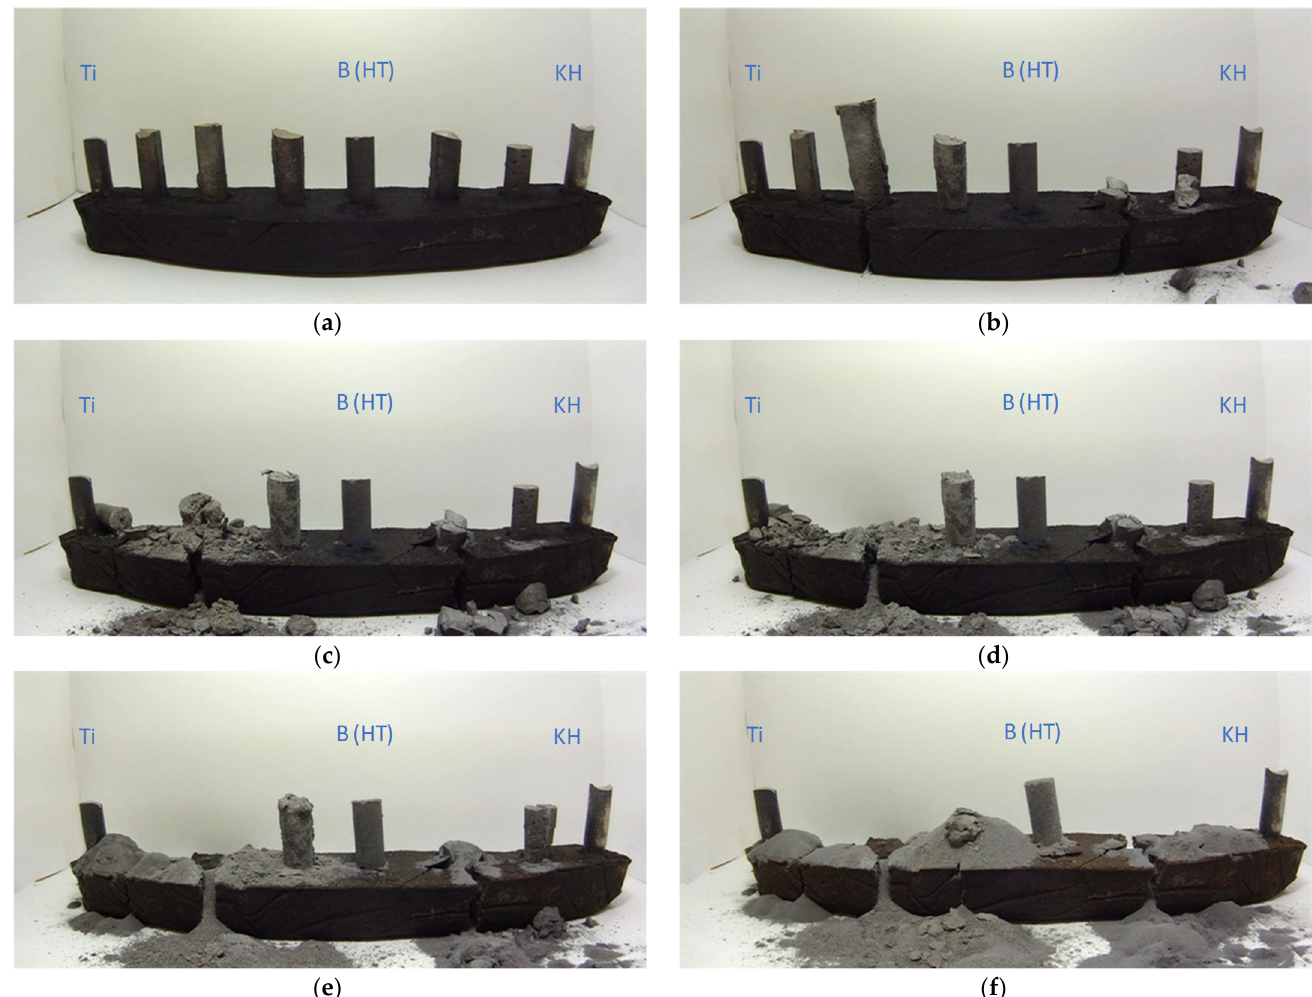
Figure 7. Self-destruction of different types of high-aluminum cast iron within 7 months after casting: Ti—titanium addition, B(HT)—boron modification and after heat treatment, KH—know-how of author; other samples were characterized by a variety of high-aluminum cast-iron structures consisting mainly of carbide eutectics Al 4 C 3 and hypereutectic Al 4 C 3 carbides. The images were taken over a period of four days ( a ), 40 days ( b ), 76 days ( c ), 112 days ( d ), 146 days ( e ), 184 days ( f